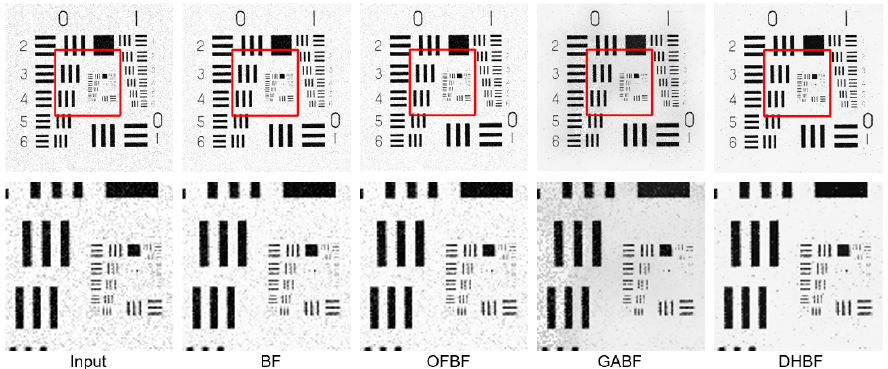
Figure 11. Visual comparison of the representative sample for image smoothing on USC-SIPI.